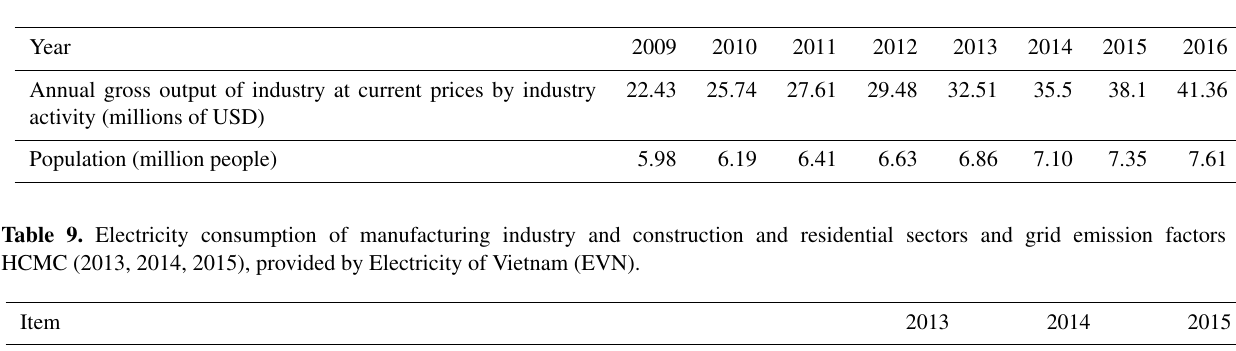
Table 8. Annual gross output of industry at current prices by industry activity in HCMC and population of HCMC over the years provided by the HCMC Statistical Yearbook.